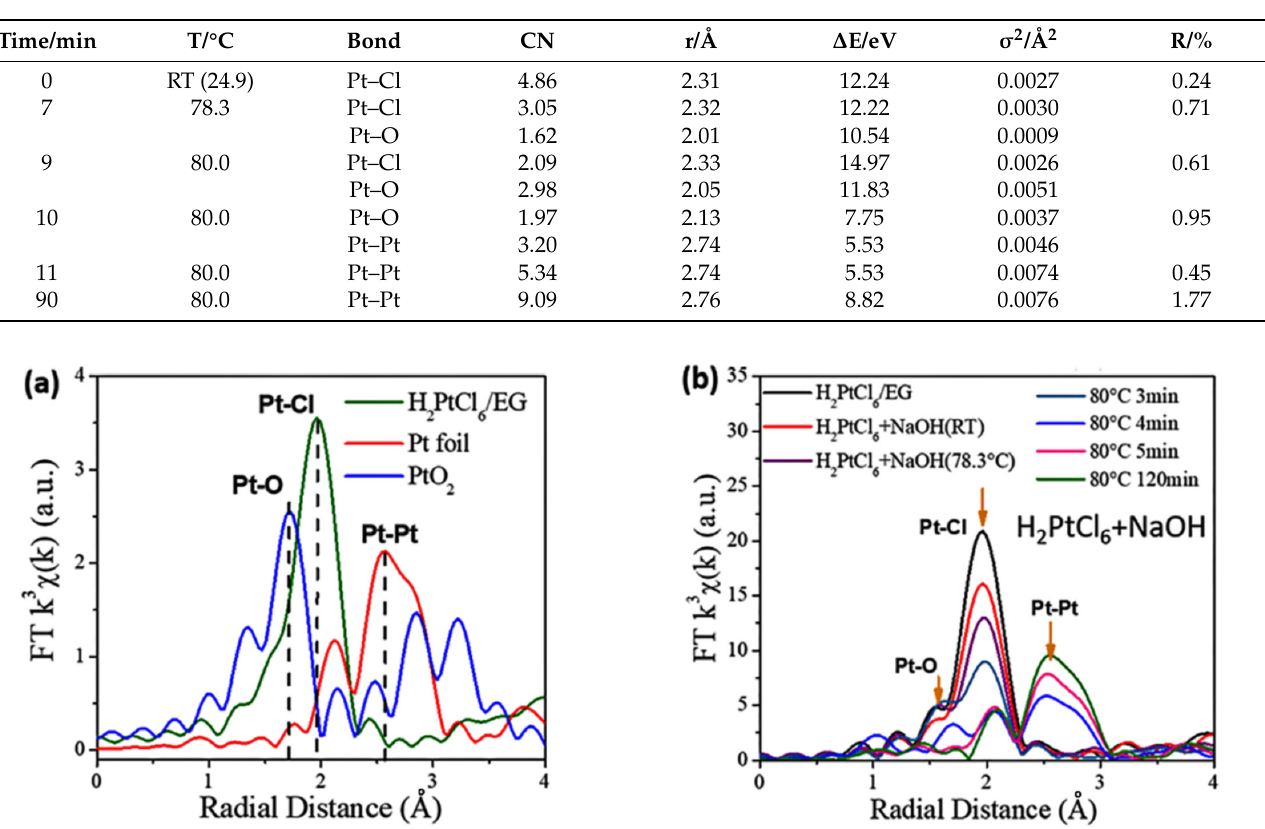
Table 2. Fitting parameters of the Pt–Cl, Pt–O, and Pt–Pt bonds obtained from the Pt L 3 ‐ edge EXAFS spectra of reaction mixture for preparing unprotected Pt nanoclusters. Reproduced with permission,